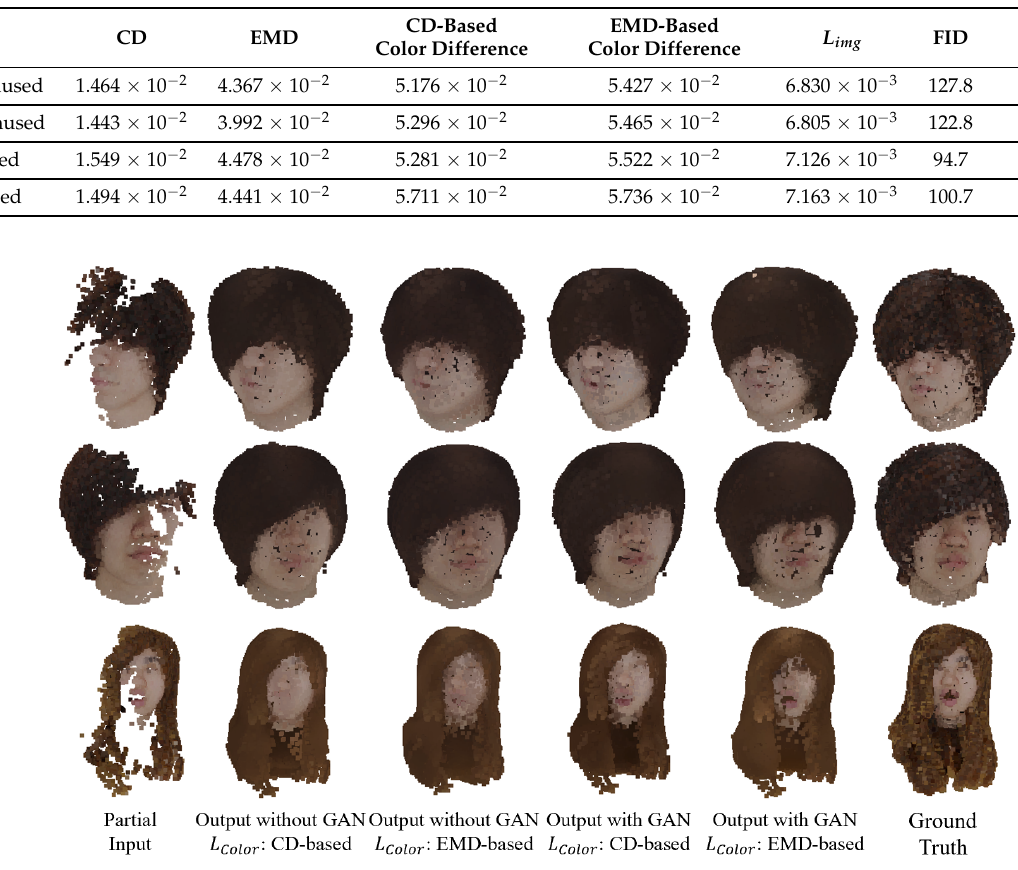
Figure 7. Completion results using